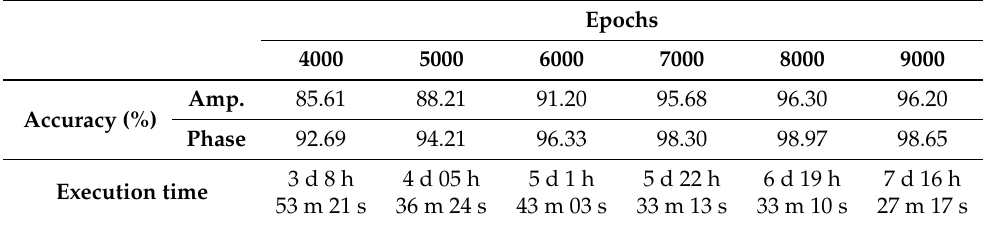
Table 6. Training results for the excited signal prediction regression network (6000 test